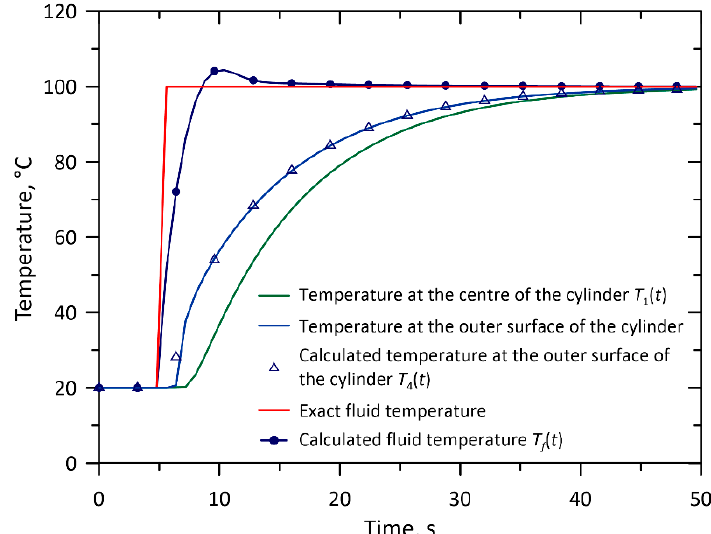
Figure 2. Fluid temperature and temperature “measured” at the axis of the 15 mm diameter thermometer and on its outer surface—comparison of the input fluid temperature with the results obtained from the solution of the inverse problem for the stepwise increase in fluid temperature.